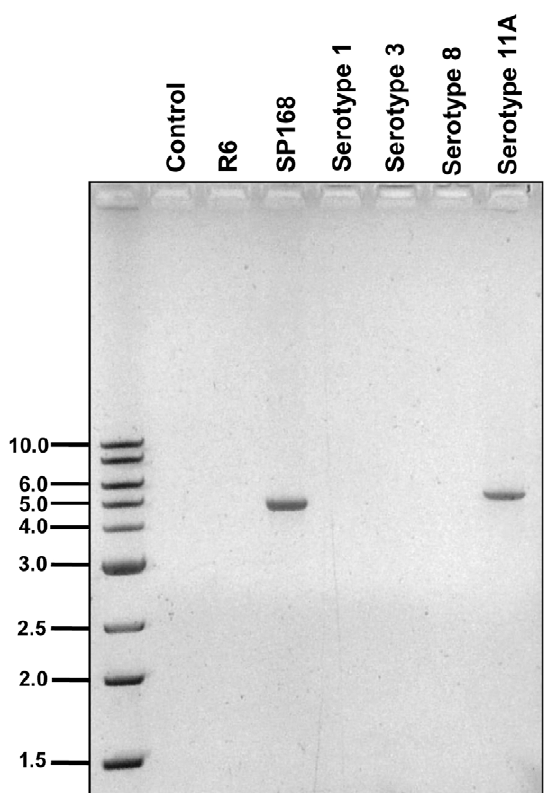
Figure 6. zmpC is present only in certain strains of S. pneumoniae . Genomic DNA isolated from all strains of S. pneumoniae under study was subjected to polymerase chain reaction to screen for the zmpC gene. Amplified products were separated on a 1% agarose/ TBE gel. Molecular weight markers are represented in kilobase pairs (kbp). Products corresponding to the bands observed at , 5 kbp were sequenced at the University of Maine DNA Sequencing Facility and identified as zmpC . Data indicated that the zmpC gene was present in S. pneumoniae strain SP168 and serotype 11A, the only strains exhibiting MUC16 sheddase activity. zmpC from S. pneumoniae strain SP168 was found to be 723 bp shorter than that of serotype 11A. The two sequences are 86.5%